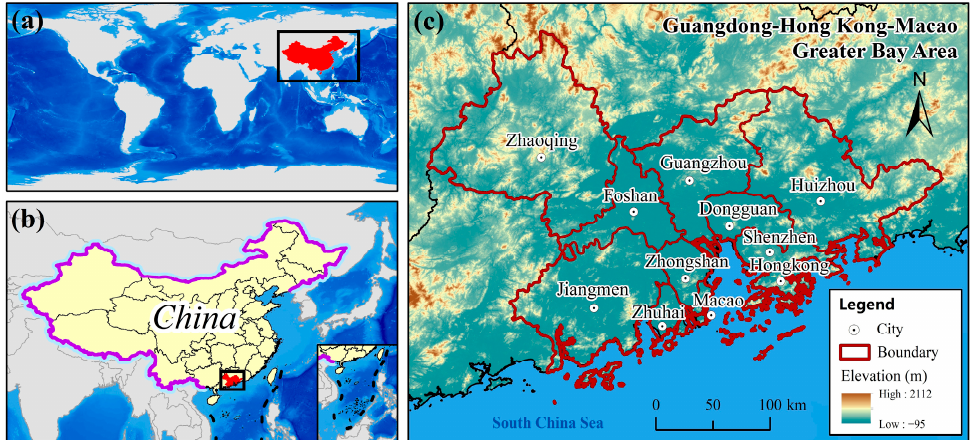
Figure 4. Map of the GBA. ( a ) is China's position in the world. ( b ) is the location of the Guangdong-Hong Kong-Macao Greater Bay Area in China. ( c ) is the area map of Guangdong-Hong Kong-Macao Greater Bay Area.